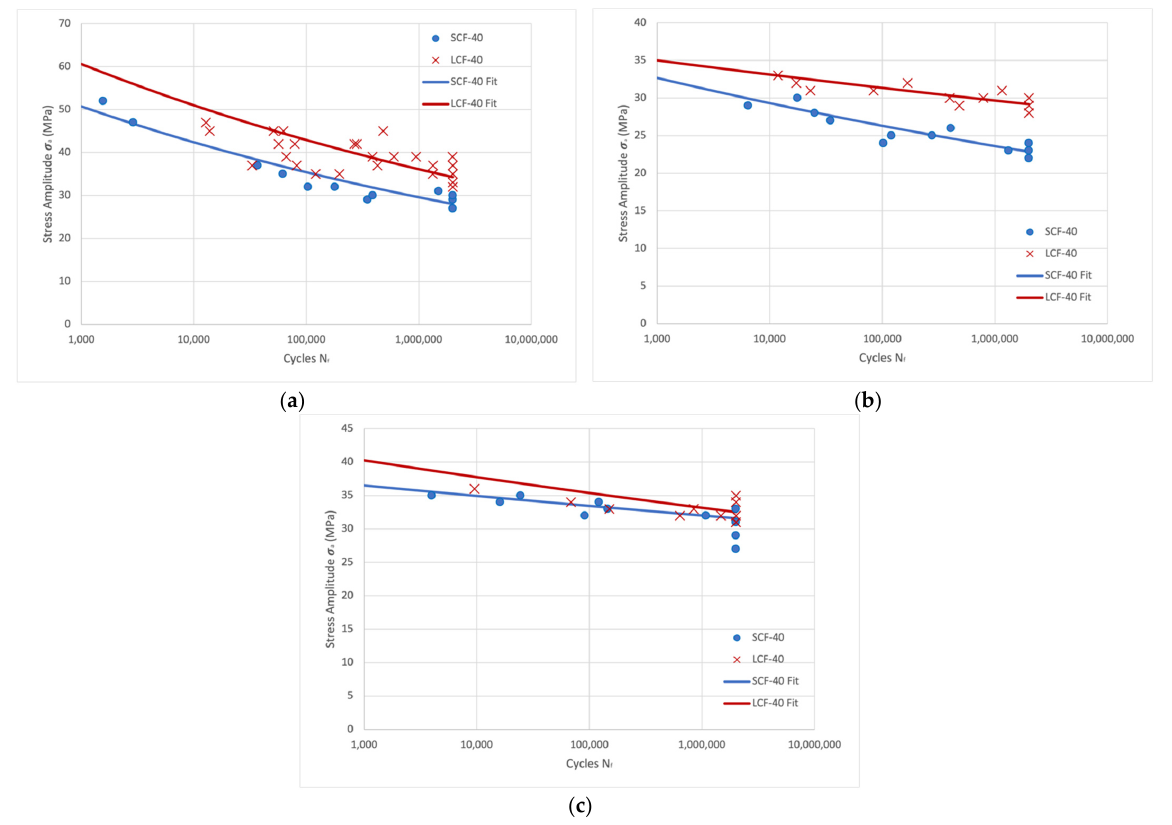
Figure 5. Fatigue test results at 120 °C for SCF and LCF materials for, ( a ) R = − 1, ( b ) R = 0.1, ( c ) R = 10. Table 4. Fatigue test Basquin equation fit parameters for 120 ◦ C